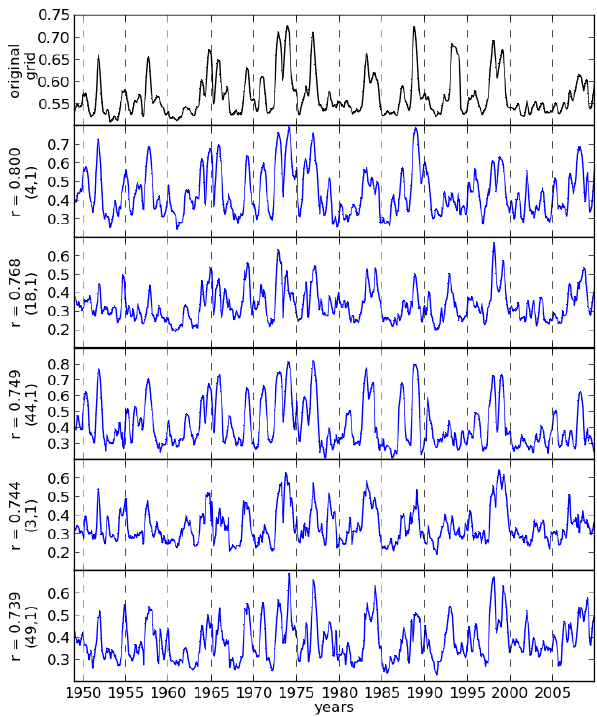
Fig. 6. The temporal evolution of the inter-regional components. Visualisation as in Fig. 3.